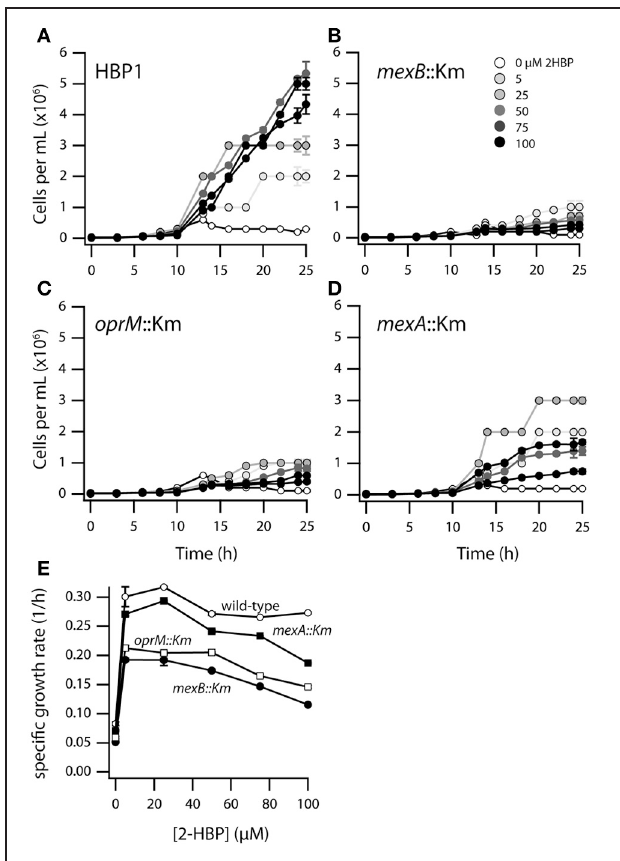
FIGURE 2 | Growth of P. azelaica HBP1 wild-type, mexA:: Km, mexB:: Km, and oprM:: Km mutants on low concentrations of 2-HBP. (A–D) Population growth over time as function of 2-HBP concentration. (E) Calculated maximum specific growth rates for wild-type or mutants as a function of 2-HBP